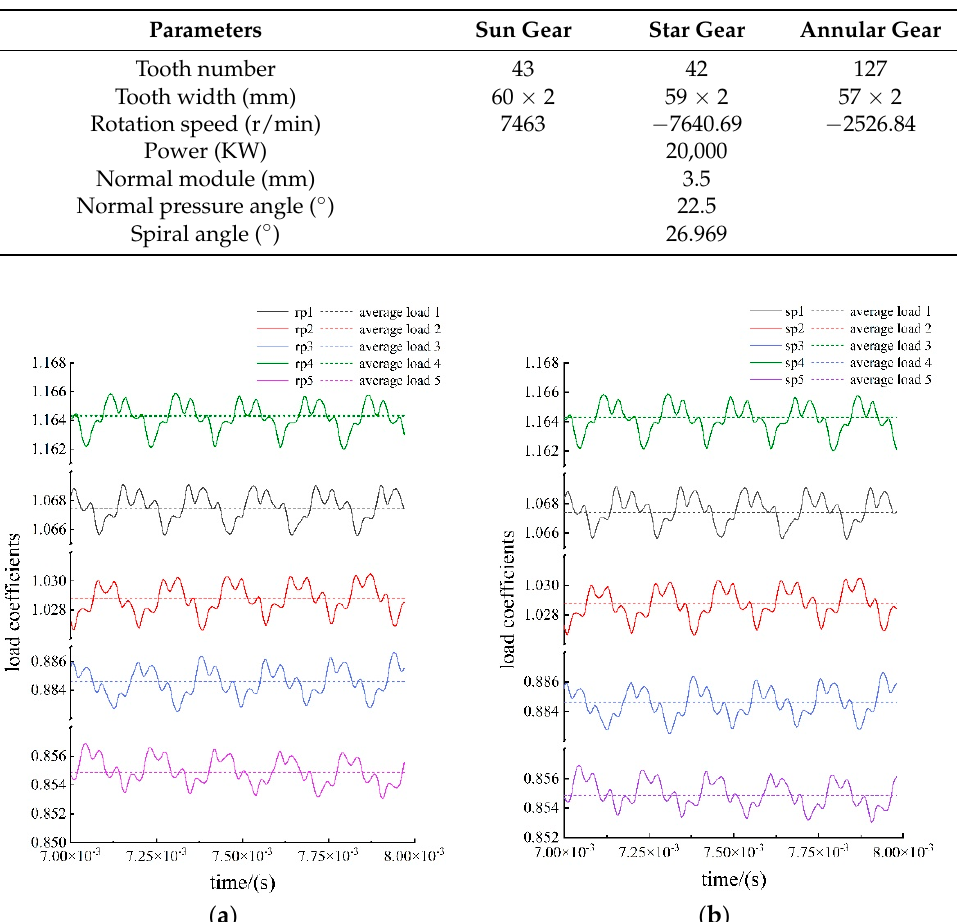
Figure 7. Load coefficient of the herringbone gear train under standard installation: ( a ) internal contact, ( b ) external contact.